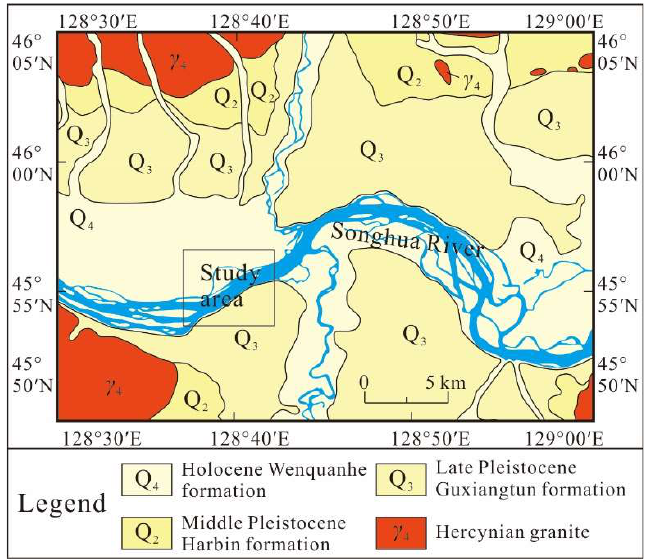
Figure 3. Geological map of the study area.